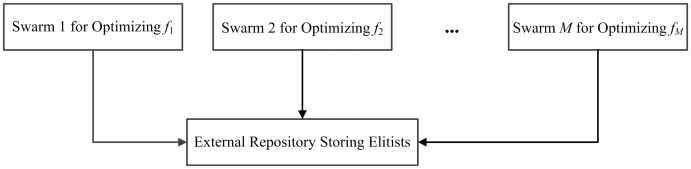
Basic architecture of MSCLPSO.